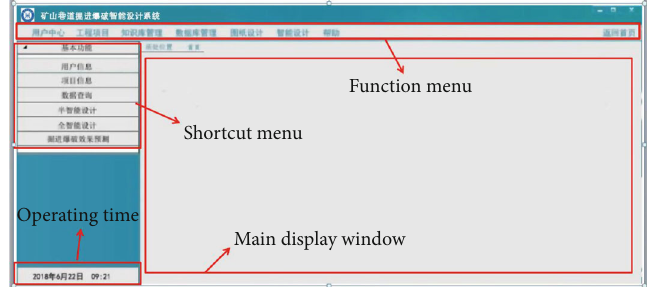
Figure 9: The operation interface of the intelligent design system for mine tunnel blasting based on